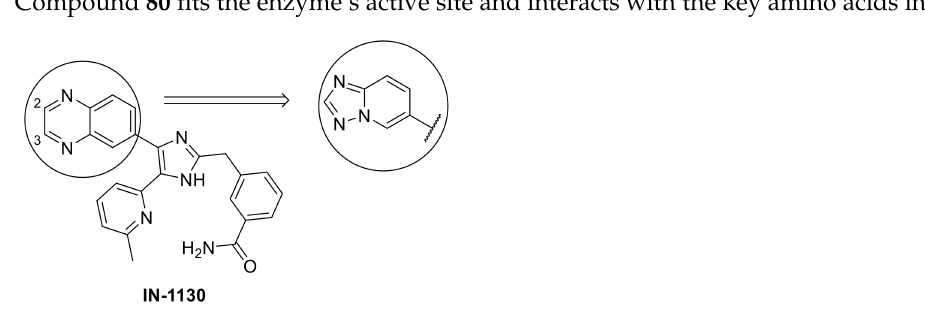
Figure 88. Preclinical candidate IN-1130 and possible oxidation site at position 2 or 3 on the quinazo- line’s heterocycle.